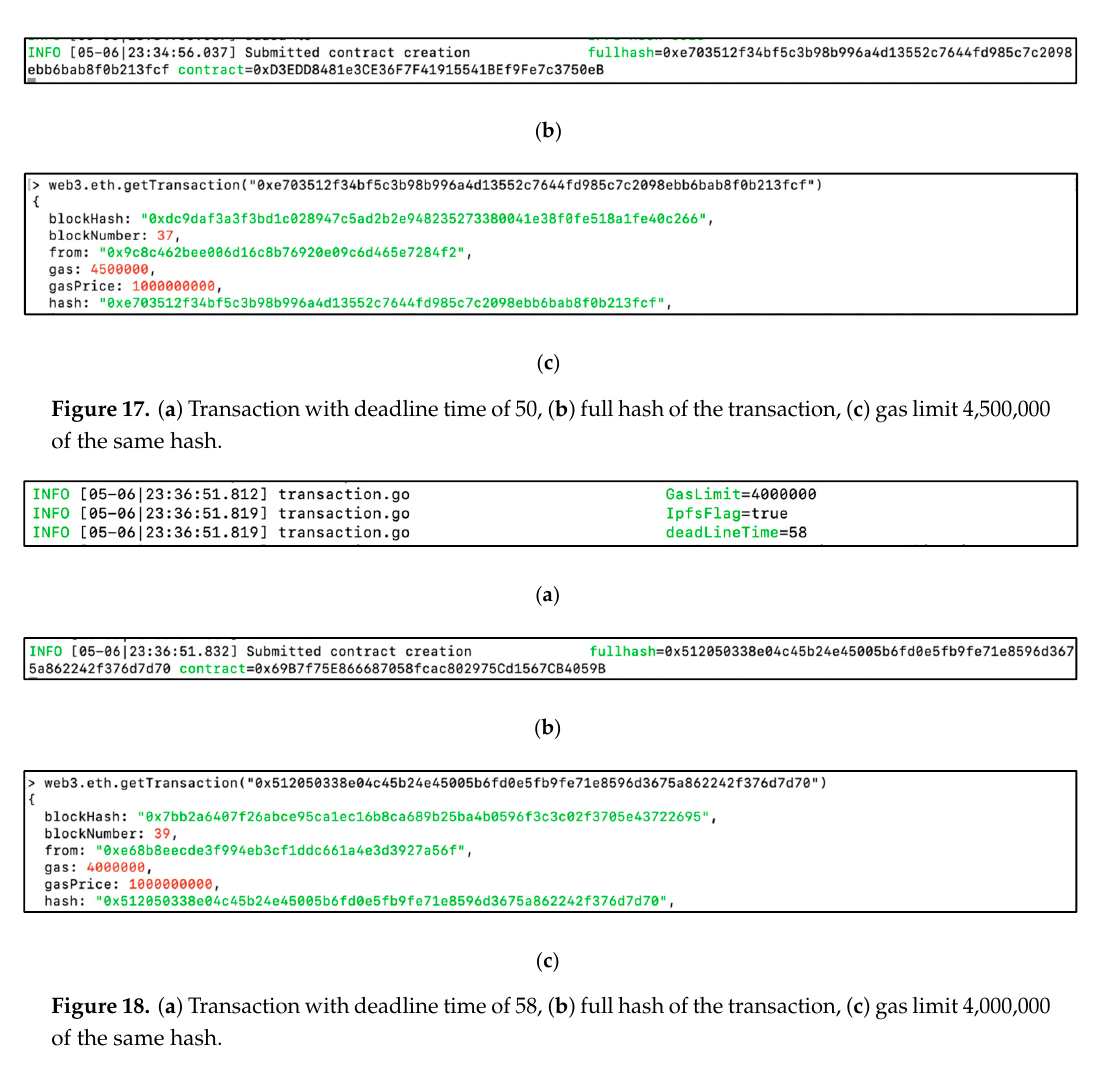
Figure 18. ( a ) Transaction with deadline time of 58, ( b ) full hash of the transaction, ( c ) gas limit 4,000,000 of the same hash.